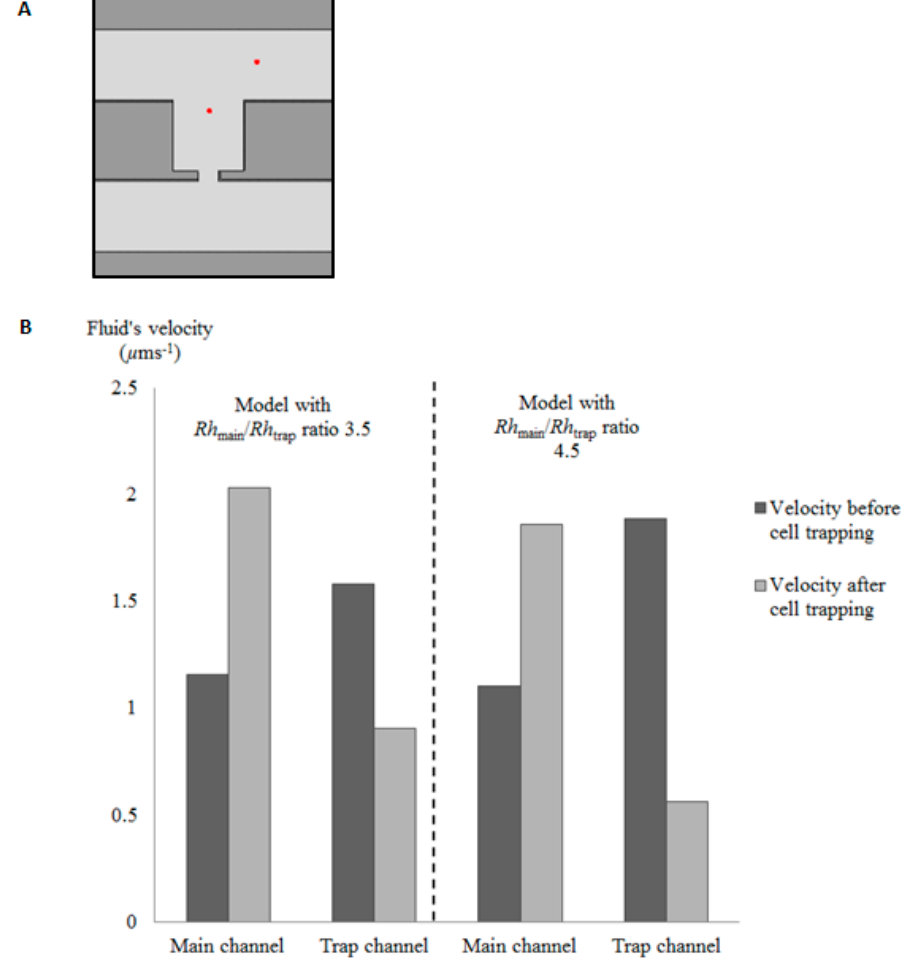
Figure 2. ( A ) Points representing velocity of fluid in the trap channel ( left side) and main channel ( right side); ( B ) graph representing velocity of fluid in trap channel and main channel for cell trapping model with Rh Main / Rh Trap ratio of 3.5 or 4.5 before and after cell trapping.